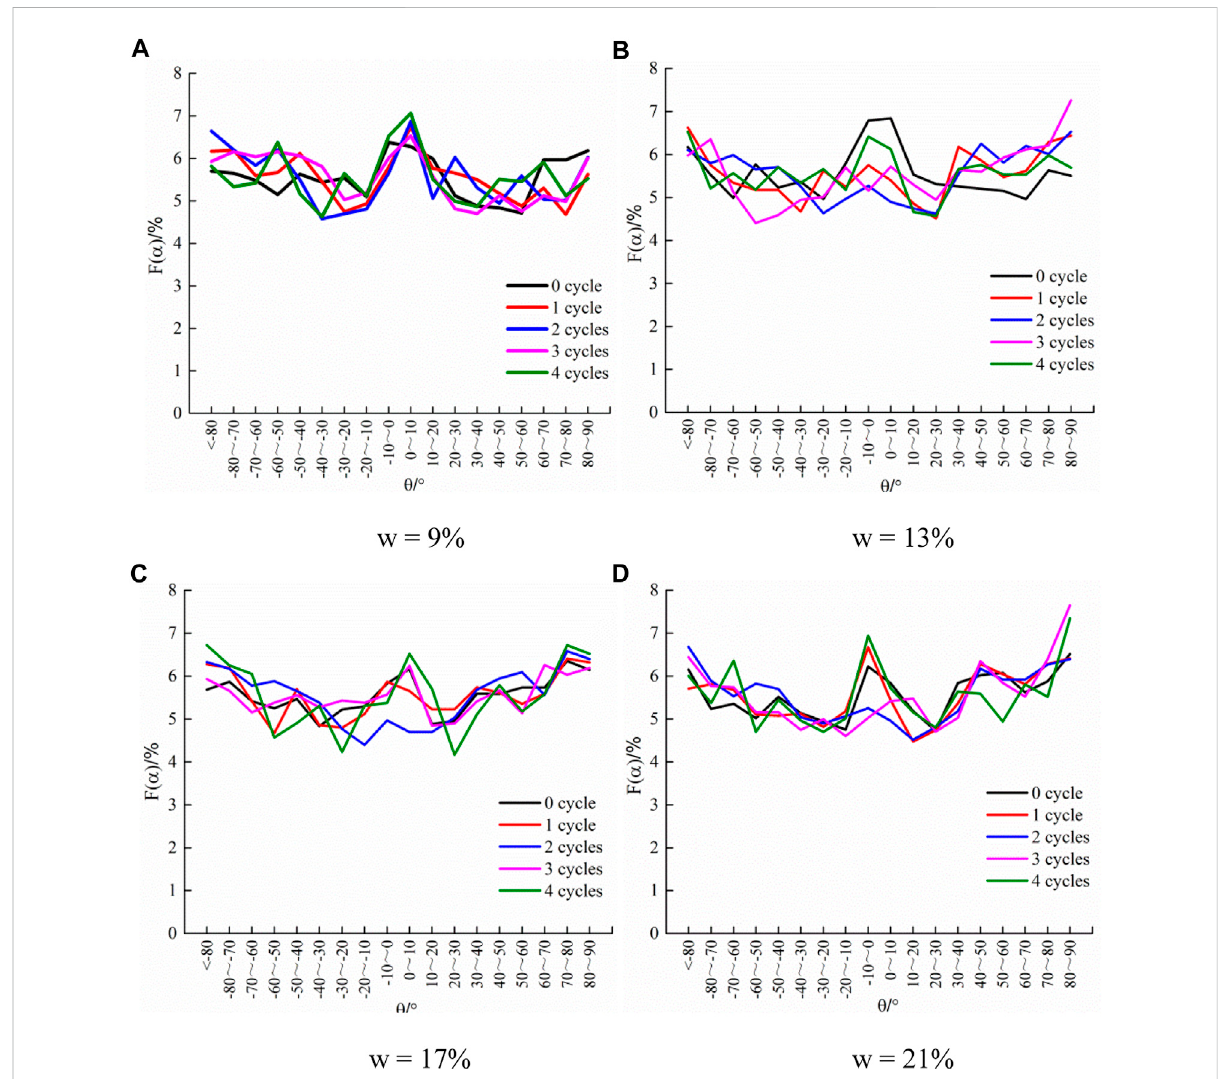
FIGURE 10 The directional frequency of the soil particles under the different DWC. (A) w = 9% (B) w = 13% (C) w = 17% (D) w =